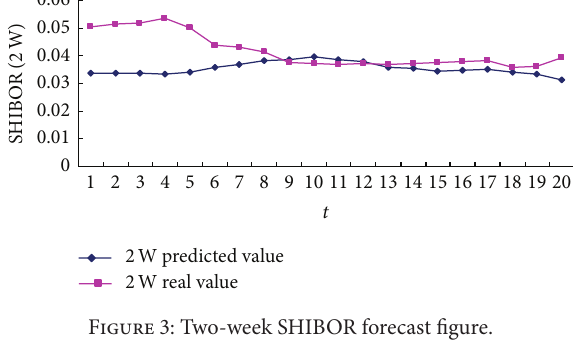
Figure 3: Two-week SHIBOR forecast figure.